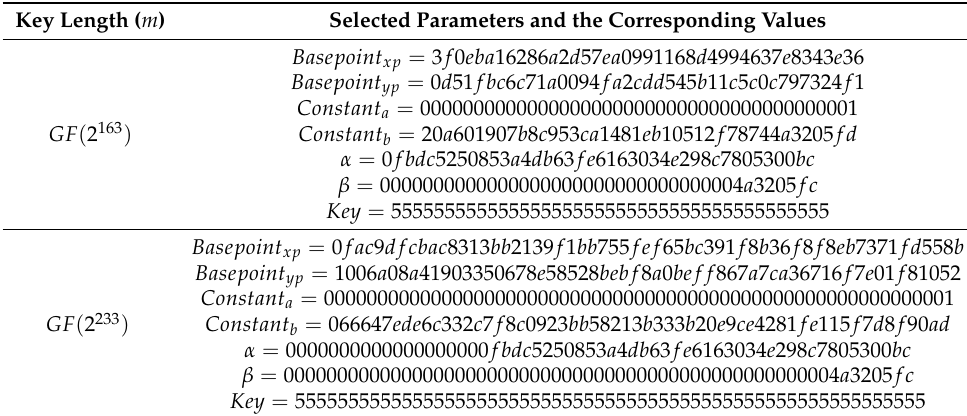
Table 3. Implementation parameters over GF ( 2 163 ) and GF ( 2 233 ) [27]. Key Length ( m ) Selected Parameters and the Corresponding